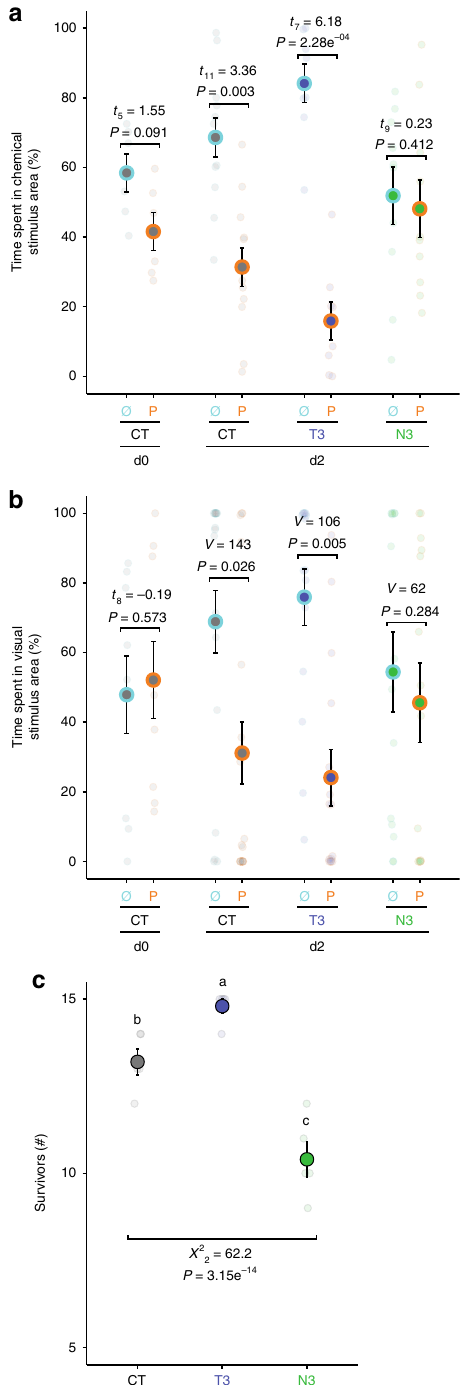
Fig. 2 Thyroid hormone signaling and Acanthurus triostegus sensory abilities and survival facing predation. a Chemical preference when facing seawater containing no-predator cue (Ø) vs seawater containing predator cue (P) along recruitment (from day 0 (d0) to d2) and across hormonal treatments (CT = control; T3 = T3 treatment; N3 = N3 treatment); n = 72. b Visual preferences when facing visual cues from two separate aquaria: a control “ fi sh-empty ” tank (Ø) vs tank with a live predator (P), across hormonal treatments; n = 114. Statistical results in a and b indicate the outputs from one-sided paired t tests or Wilcoxon signed-rank tests. c Differential survival in a predation arena of d2 A. triostegus across hormonal treatments; n = 225 fi sh in n = 5 replicates. Data are indicated as mean (opaque circles)± SE (error bars), and transparent circles indicate each data point. Letters indicate statistically different groups according to two-sided Tukey post hoc tests following COM-Poisson GLM ( χ 2 ). Source data are provided as a Source Data fi